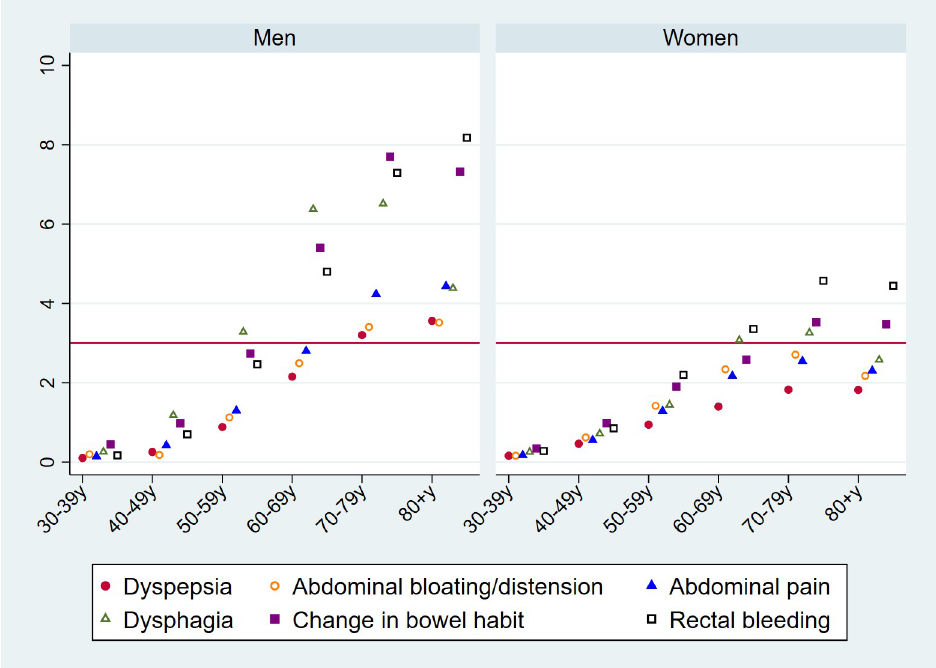
Fig 1. PPVs (%, y axis) for cancer in the year post-presentation, per studied symptom, by sex (left/right panels) and age group ( x axis). The red horizontal line represents the NICE 3% or greater PPV threshold for urgent (two- week-wait) referral for suspected cancer. Exact values from this figure are provided in S1 Table. PPV, positive predictive